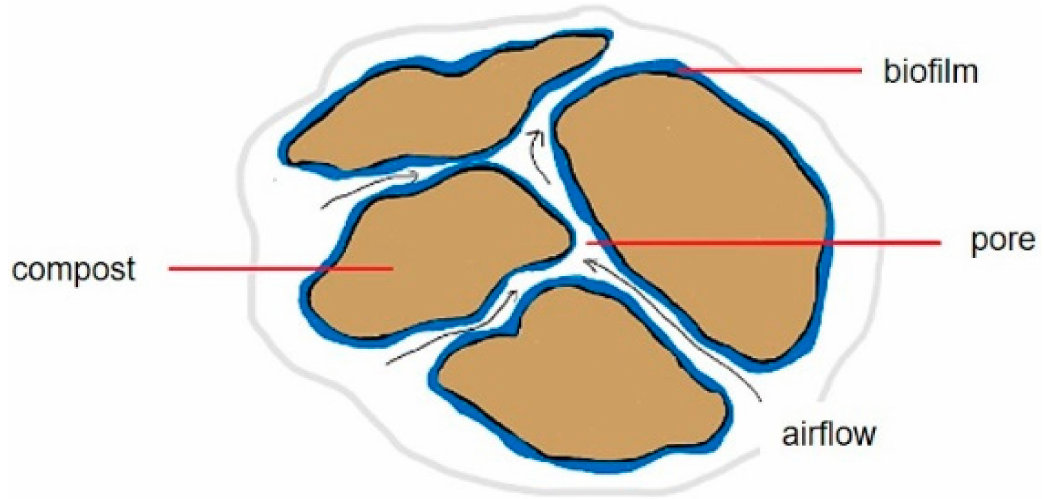
Figure 3. Porosity of